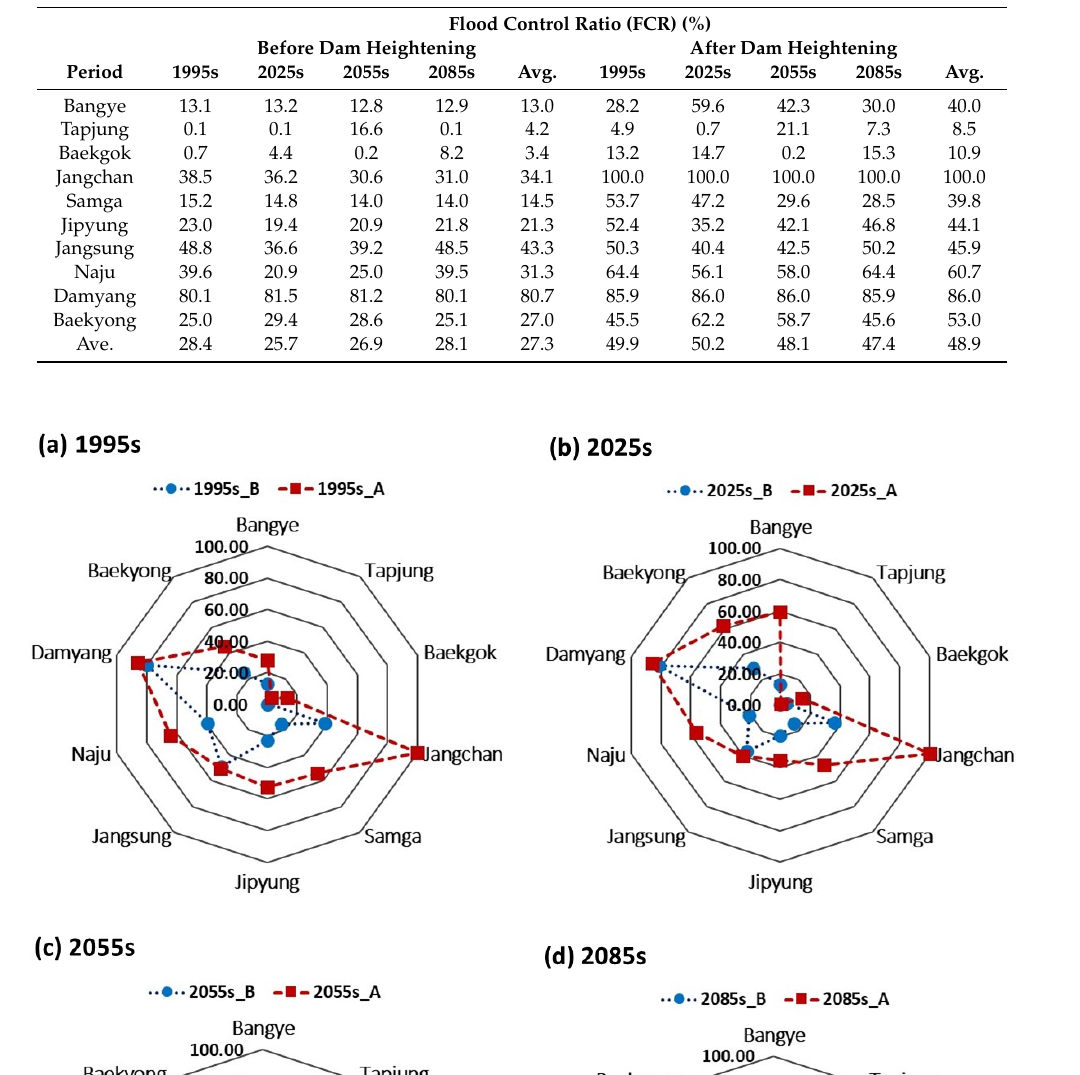
Figure 4. Box plots of flood control ratio before and after dam heightening by period. B stands for before dam heightening and A stands for after dam. 3.3. Assessment of Flood Vulnerability 3.3.1. Principal Component Analysis PCA was performed to calculate the weight of the climate exposure indicators. Table 5 and Figure 5 show the results of PCA for the climate exposure index. The total variance of the first and second PCs explains most of the indicators; the total variances of the first and second PCs were 64.7% and 25.2%. Figure 6 shows that CN80, CX3h, and CX24h were the main indicators in the first PC, and CF24h20y was the second PC’s main indicator. Table 5. Matrix of factor loadings of climate exposure.